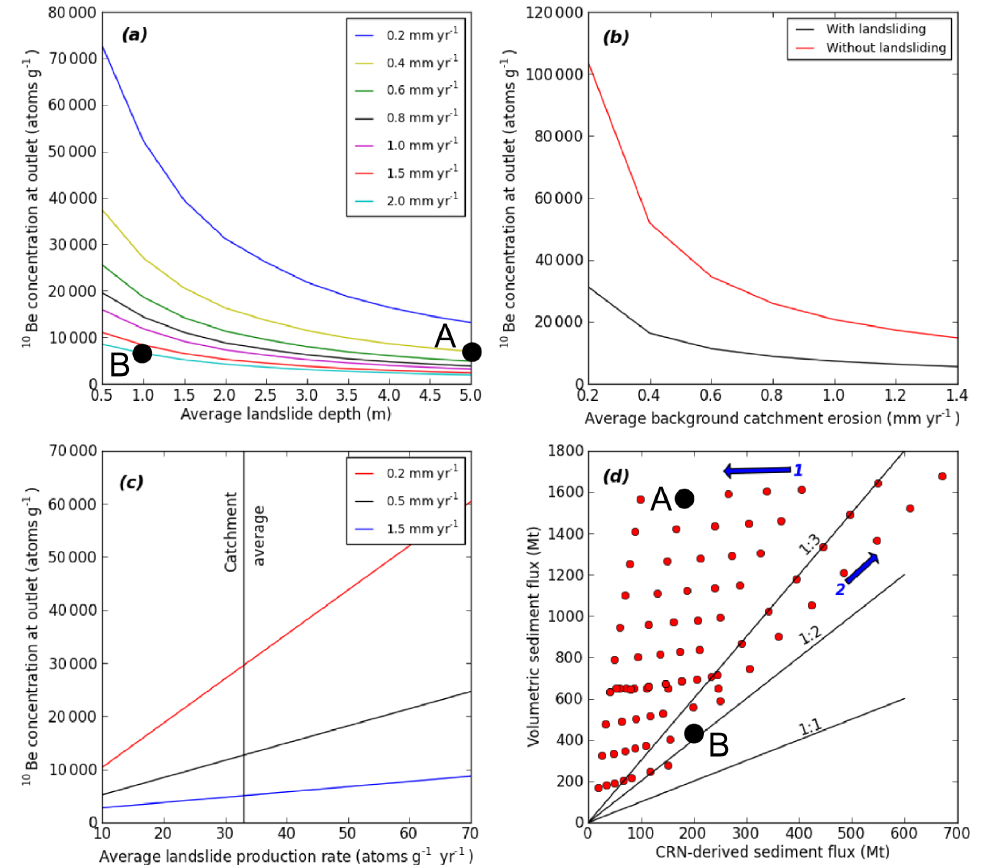
Figure 8. (a) Variations in 10 Be concentration predicted at the outlet in response to increasing landslide depth and as a function of background erosion rates (represented by coloured lines). (b) Outlet 10 Be concentration as a function of background erosion rate (where all other parameters are constant at default values – see Table 3), for a system undergoing no landsliding (red line – where erosion is driven purely by background erosion) and another with 2m deep landsliding over 0.5% of the catchment area (black line). (c) Outlet 10 Be concentration under varying average landslide 10 Be surface production rates (based on Table 2) and background erosion rates (coloured lines). The black vertical line represents the whole Ganga-catchment-averaged production rate of ∼ 33atomsg − 1 yr − 1 . (d) Comparison of volumetric and CRN-derived sediment fluxes from analysis in panels (a) – (c) . The blue arrow labelled 1 shows the effect of decreasing background erosion rate, and the blue arrow labelled 2 shows the effect of increasing landslide depth and/or landslide 10 Be production rate. The black dots in panels (a) and (d) represent scenarios A and B which are discussed in more detail later and in Fig.